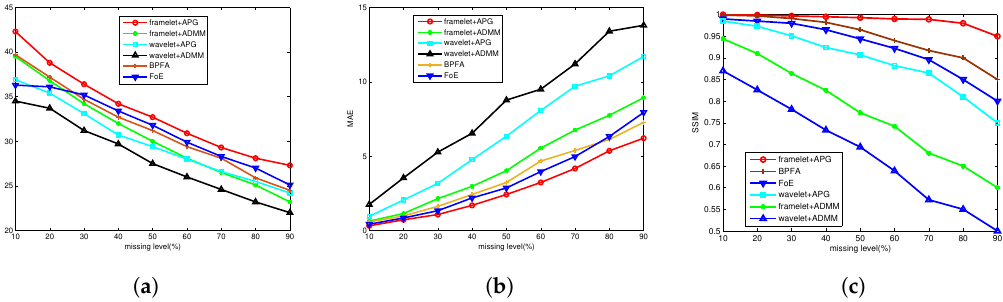
Figure 5. Results of PSNR, MAE, and SSIM at different missing levels. ( a )PSNR, ( b )MAE, ( c )